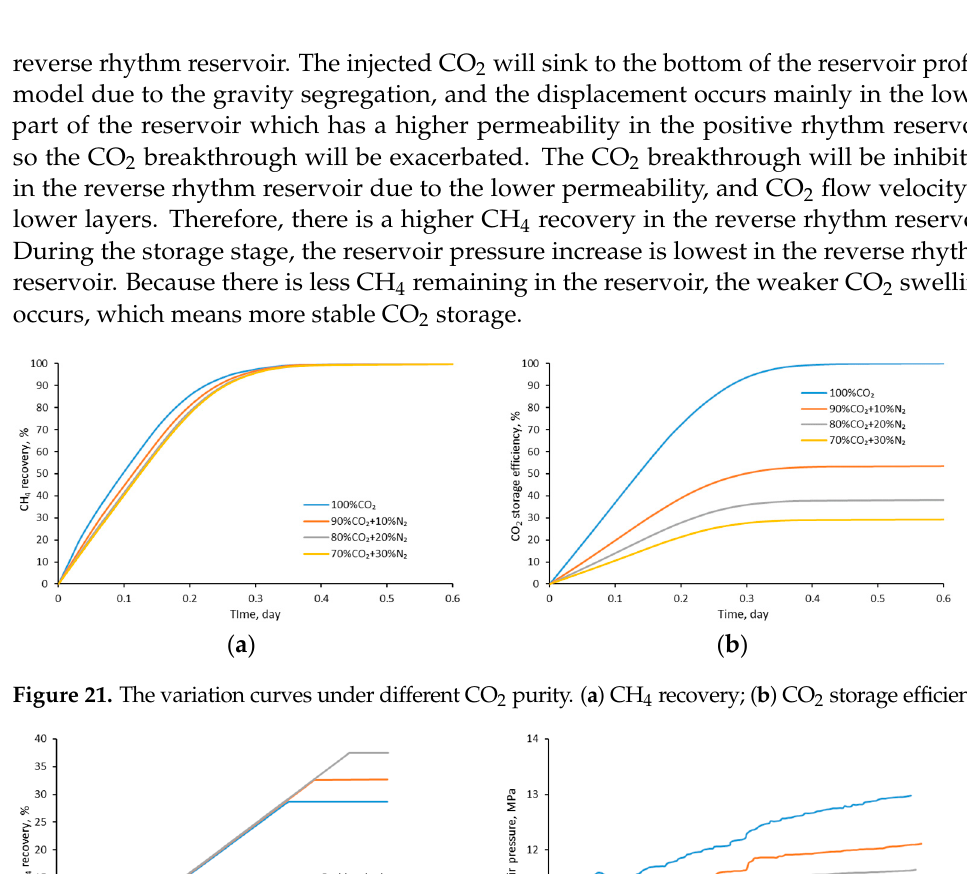
Figure 21. The variation curves under different CO 2 purity. ( a ) CH 4 recovery; ( b ) CO 2 storage effi- ciency.